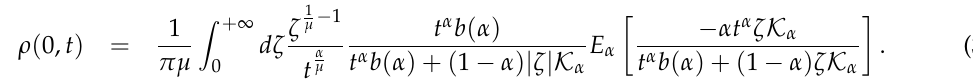
= 10 2 , and different α K